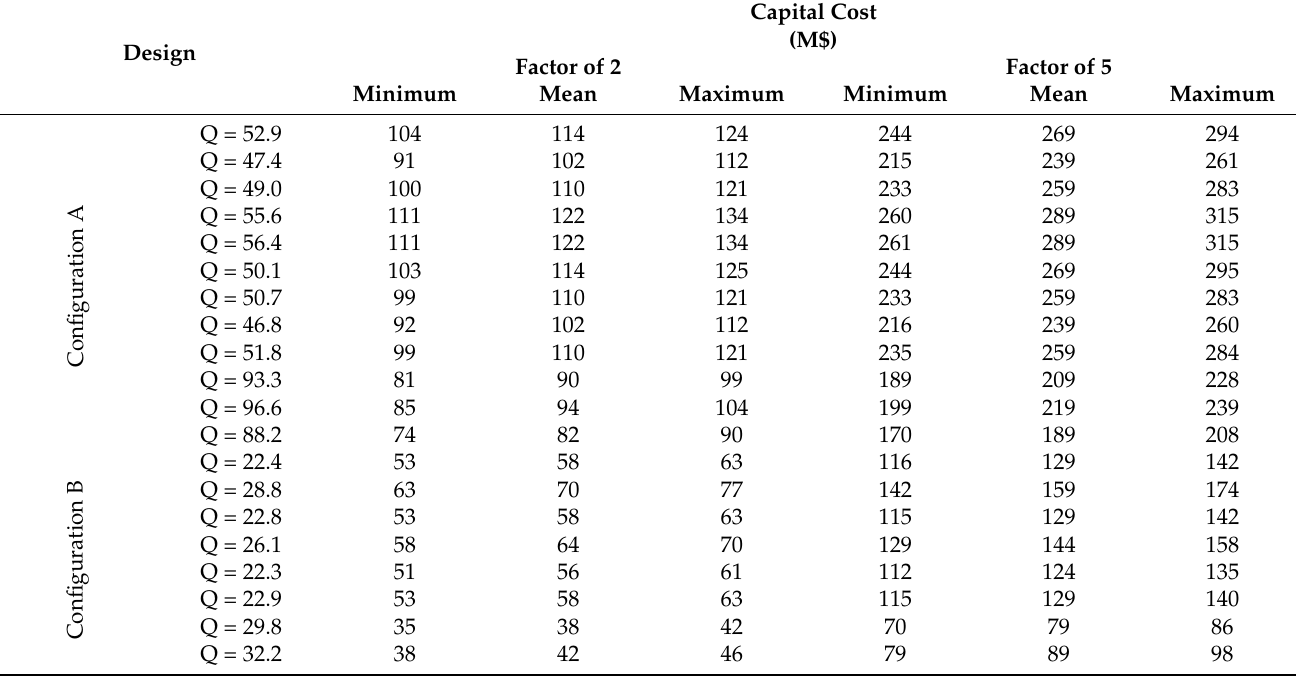
Table 7. Capital cost for each simulated